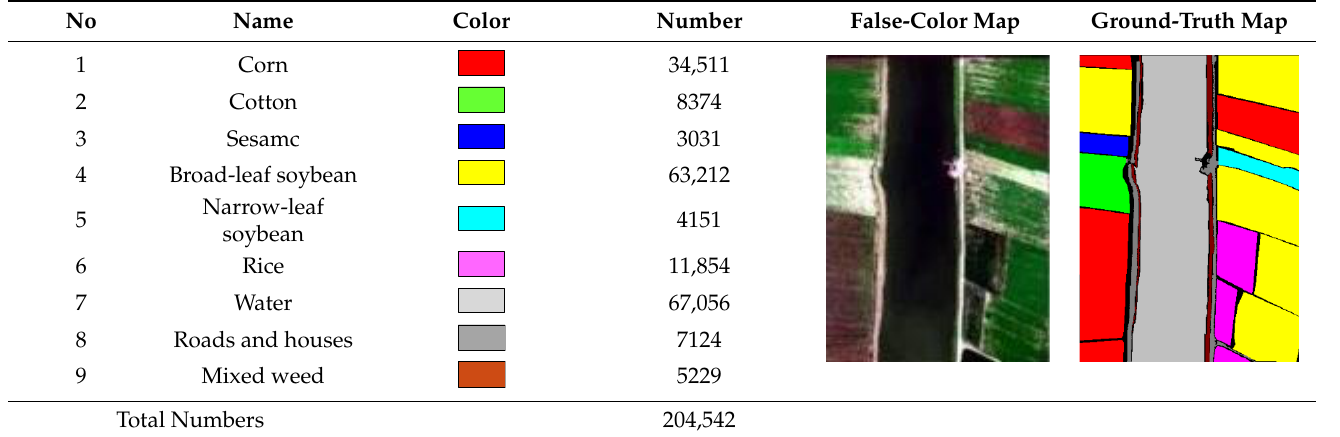
Table 1. Salinas Dataset Labeled Sample Counts.